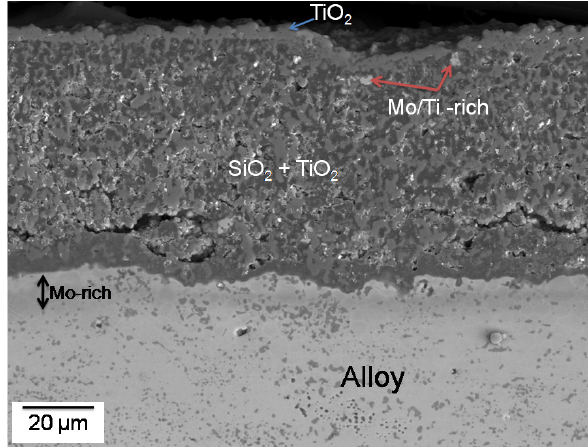
Figure 9: Cross-sectional BSE image indicating the presence of a TiO rich thin outer layer, and a Mo-rich layer at the scale/alloy 2